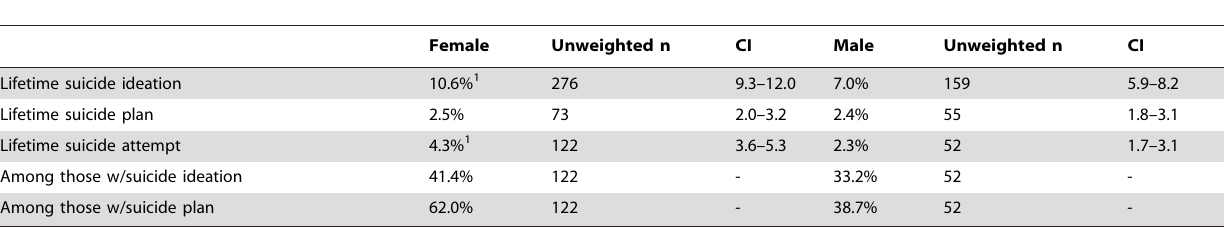
Table 1. Prevalence (%) of lifetime suicide ideation, plan, and attempts among women (n=2441) and men (n=1899) in the NISHS.